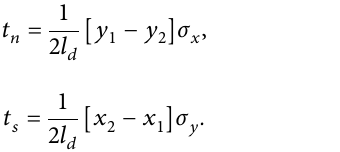
Figure 9: Projection of the discontinuity to the opposite side to node